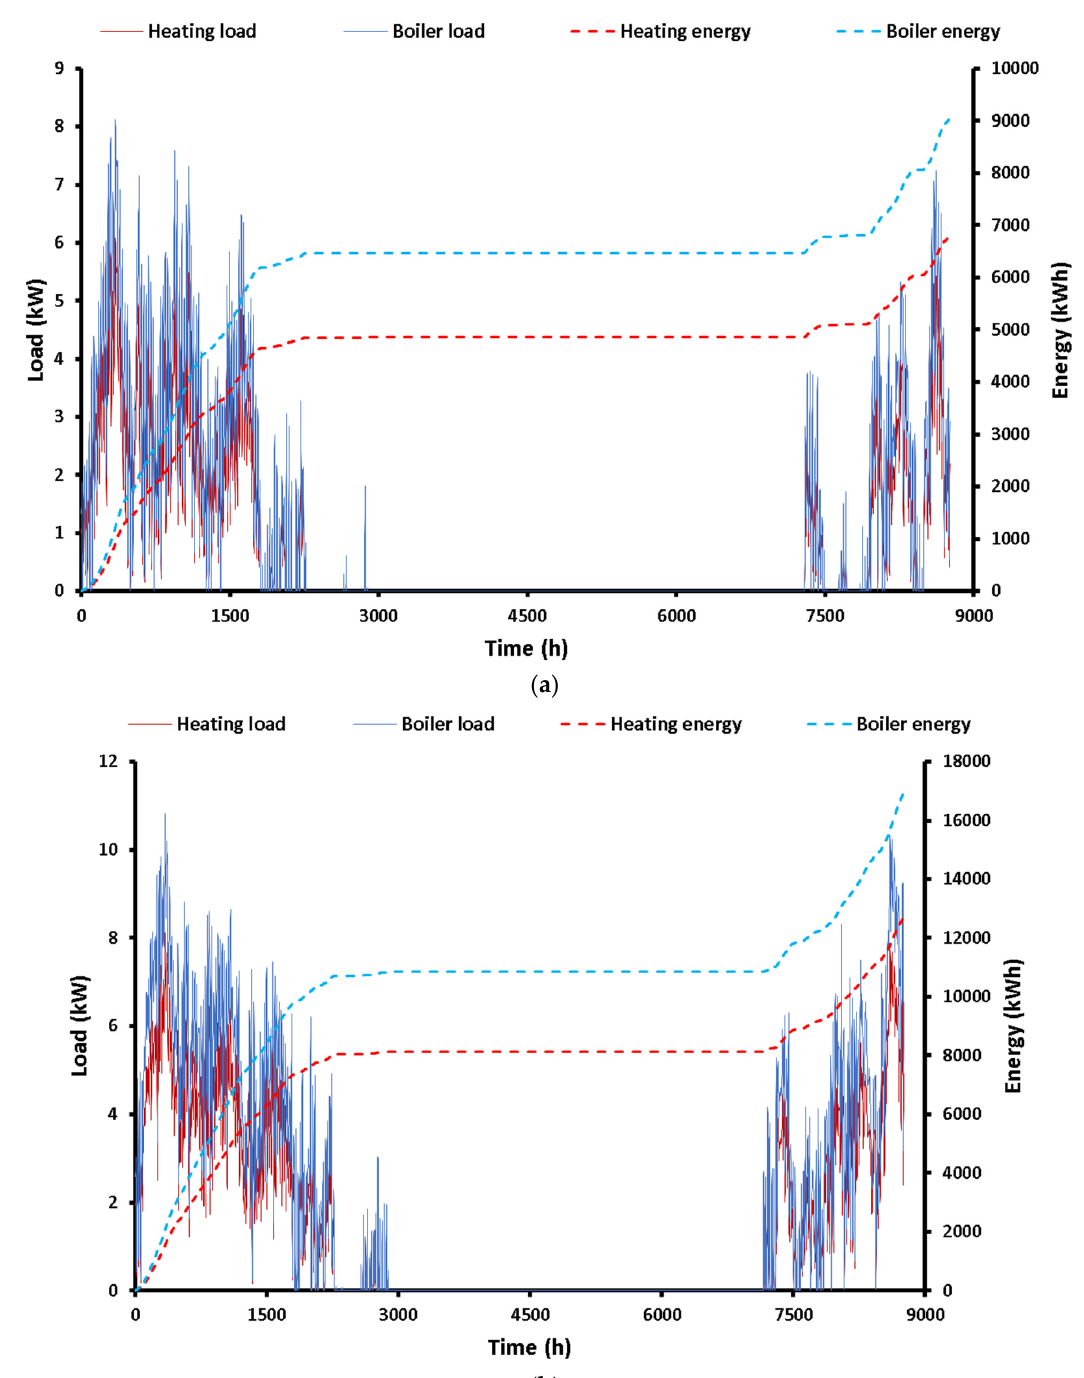
Figure 13. Boiler system: loads in [W] and cumulative energy in [kWh] for heating for ( a ) Athens (Zone B) and ( b ) Thessaloniki (Zone C).